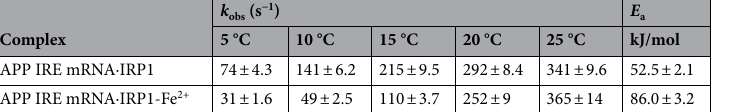
Table 3. Temperature-dependent observed rate constants of APP IRE-mRNA binding to IRP1 with and without Fe 2+ .